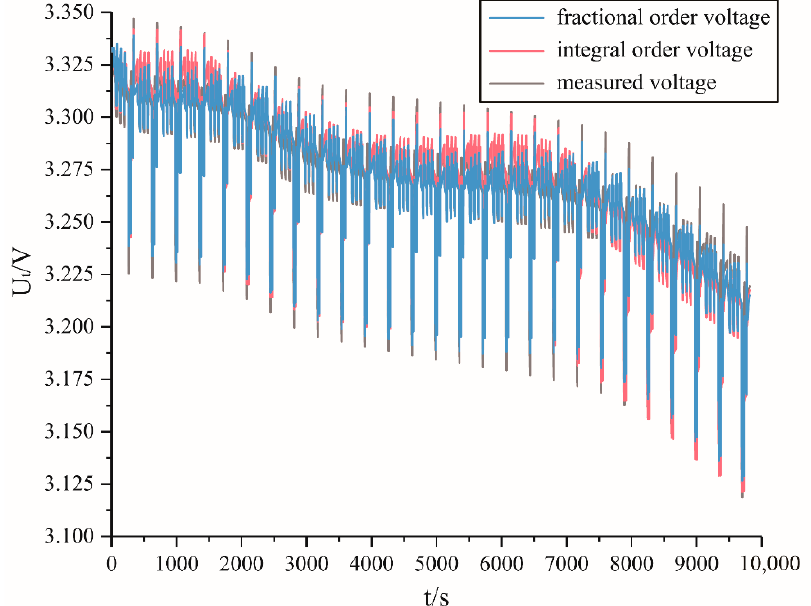
Figure 19. Comparison of battery terminal voltage filtered by FEKF and EKF under 26 continuous DST conditions at 28 °C.